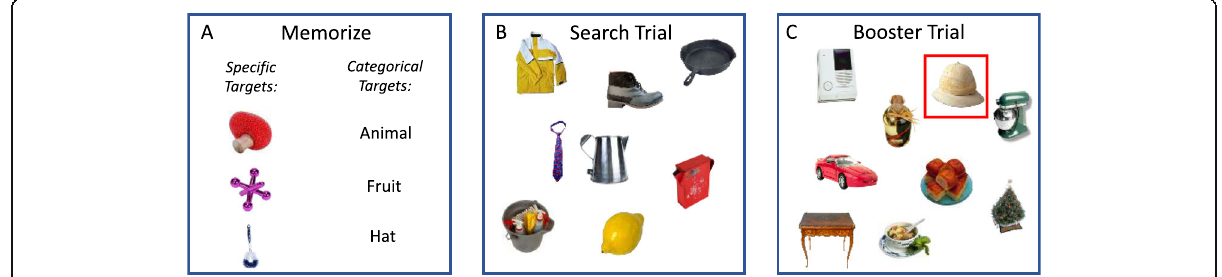
Fig. 1 The mixed hybrid search paradigm. a . Observers first memorize a set of specific and categorical targets. b . After passing a memory test (not pictured), they search for instances of any of these targets in arrays of distractor objects. c . In Block 2 of Experiments 1a and 1b, 10% of trials were non-search trials on which one item was highlighted with a red box. Two thirds of the highlighted items were categorical targets, and one third were